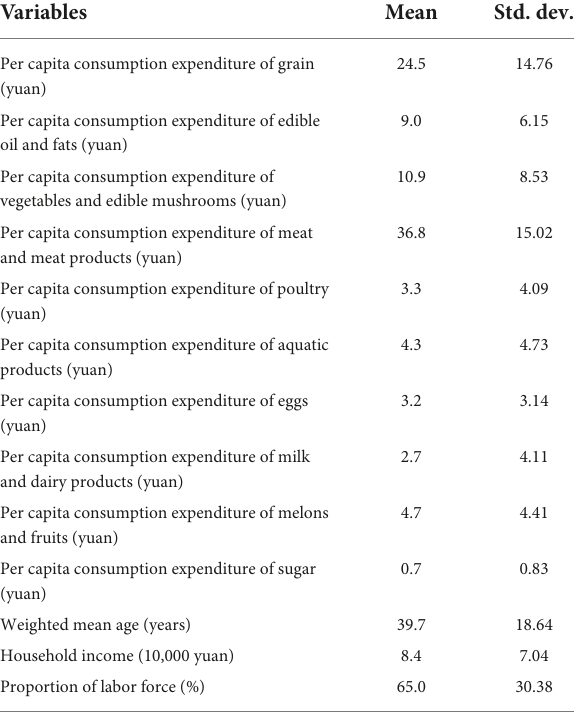
TABLE 1 Descriptive statistics of continuous variables ( N =